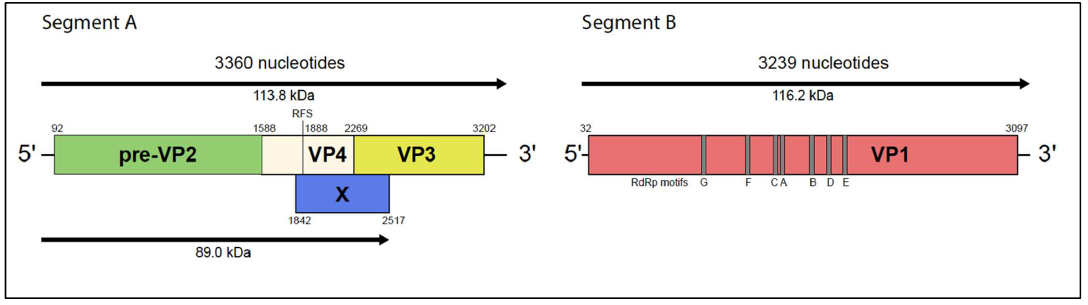
Figure 2. Ultrastructure of entomobirnavirus GMC-202 in C6/36 mosquito cells. (A) Paracrystalline agglomeration of virus particles in the cell cytosol. N = nucleus of adjacent cell. Bar = 1 μ. (B) Higher-power image of the agglomeration showing the details of virion ultrastructure. Bar = 100 nm.